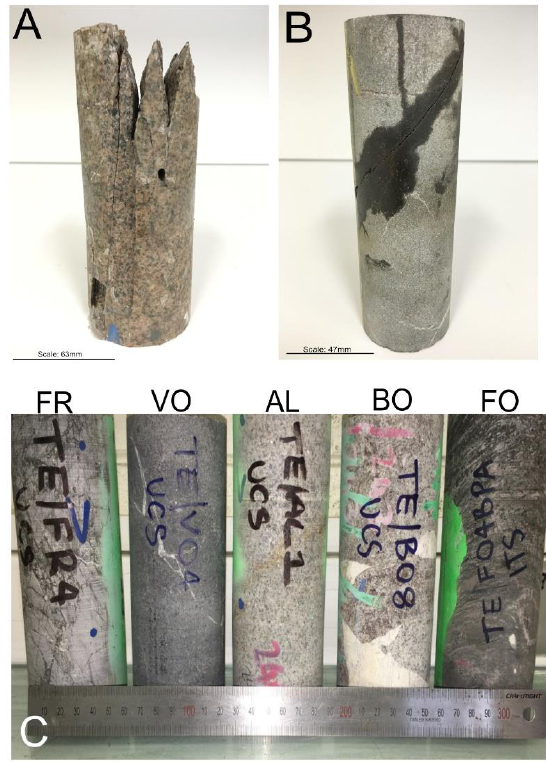
Figure 1. Photographs of the two reference samples ( A , B ); they are the least altered and